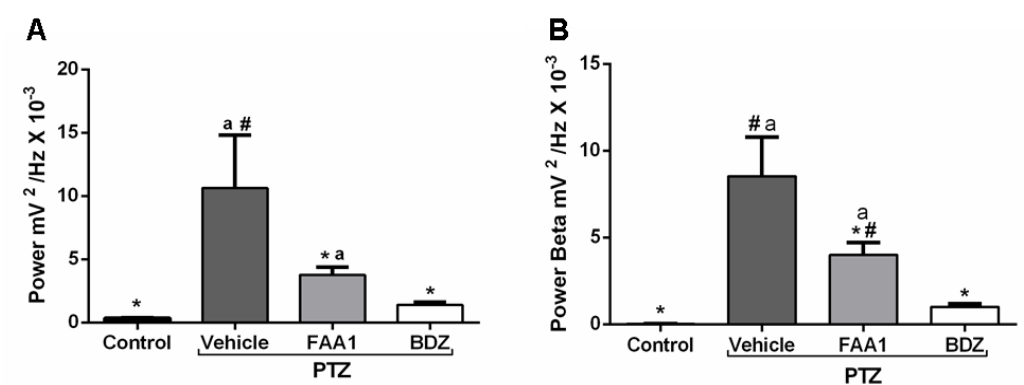
Figure 7. Mean total power records ( A ) and Beta oscillations ( B ) of control, vehicle, BDZ, and FAA1 mice groups after PTZ (60 mg/kg) administration. Results in mV 2 /Hz × 10 −3 and represent mean ± SD ( n = 9). Statistical difference in relation to the vehicle group (*) ( p < 0.0001; F = 28.61); BDZ (#) ( p < 0.05)